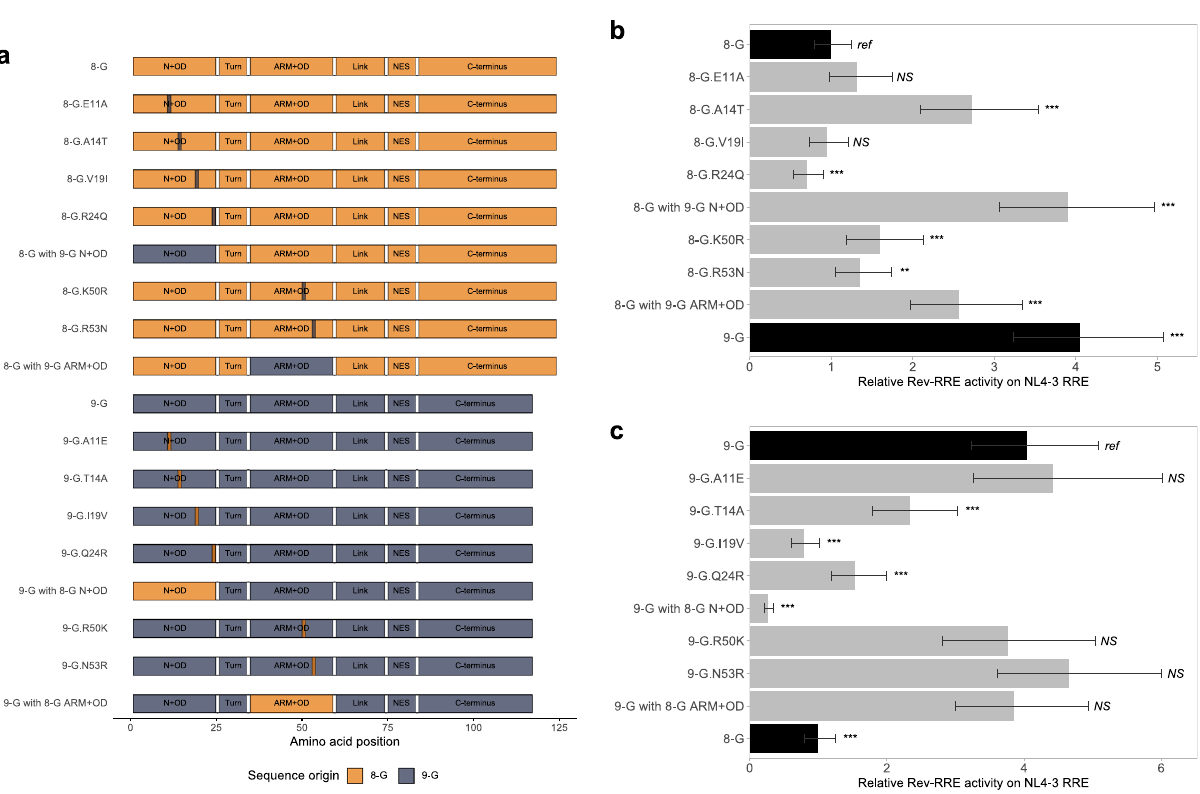
(Fig. S1 #21) mutant displayed significantly lower activity ( p = 0.001). Reciprocal substitutions in the 9-G Rev context showed a significant decrease in activity for the 9-G.T14A (Fig. S1 #34), 9-G.I19V (Fig. S1 #43), and 9-G.Q24R (Fig. S1 #46) mutants relative to native 9-G Rev, while the 9-G.A11E (Fig. S1 #33) substitution did not change activity (Fig. 4c). Two amino acid differences occurred within the ARM and second portion of the OD at positions 50 and 53. Both the 8-G.K50R (Fig. S1 #22) and the 8-G.R53N (Fig. S1 #23) substitutions increased functional activity over native 8-G Rev on the NL4-3 RRE ( p < 0.01) (Fig. 4b). The corresponding substitutions 9-G.R50K (Fig. S1 #47) and 9-G.N53R (Fig. S1 #48) did not alter activity relative to native 9-G Rev (Fig. 4c). displayed consistently lower activity ( p ≤ 0.01 for all comparisons).